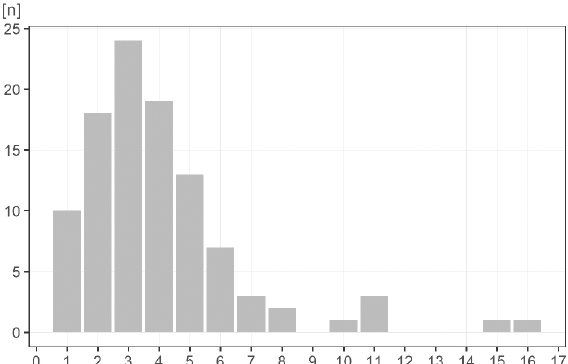
Fig. 4. Number of time points involved in the records (note: figure include the FC).